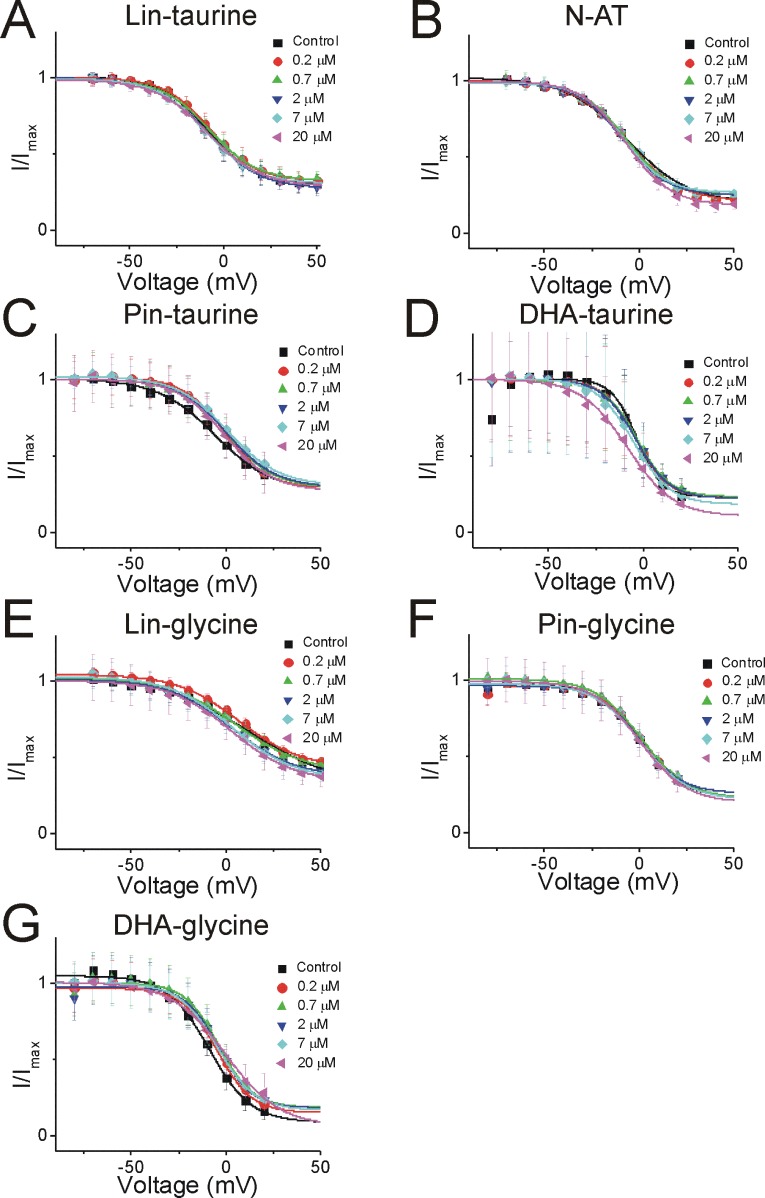
Internally normalized steady state inactivation curves for Cav1.2/β3/α2δ.(A–G) PUFA-induced effects on Nav1.5/β1 voltage dependent inactivation normalized by each concentration for: (A) Lin-taurine, (B) N-AT, (C) Pin-taurine, (D) DHA-taurine, (E) Lin-glycine, (F) Pin-glycine, and (G) DHA-glycine.